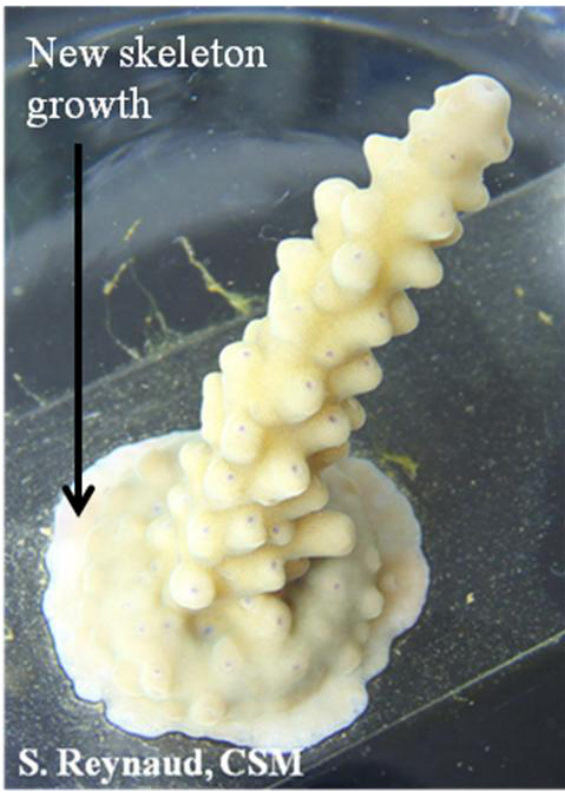
Fig. 1. Normal light picture of Acropora sp. tip adhered onto slides using underwater epoxy. (Slide width = 2.6 cm).